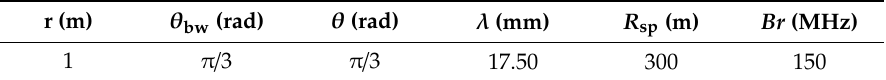
Table 1. The ArcSAR system